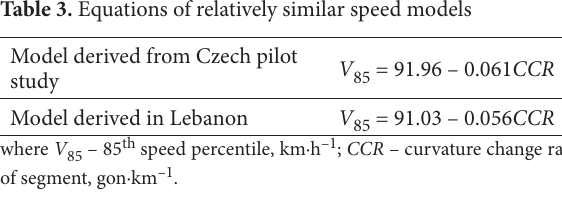
Table 4. Information on accidents which occurred on the three studied curves and in their vicinity Curve